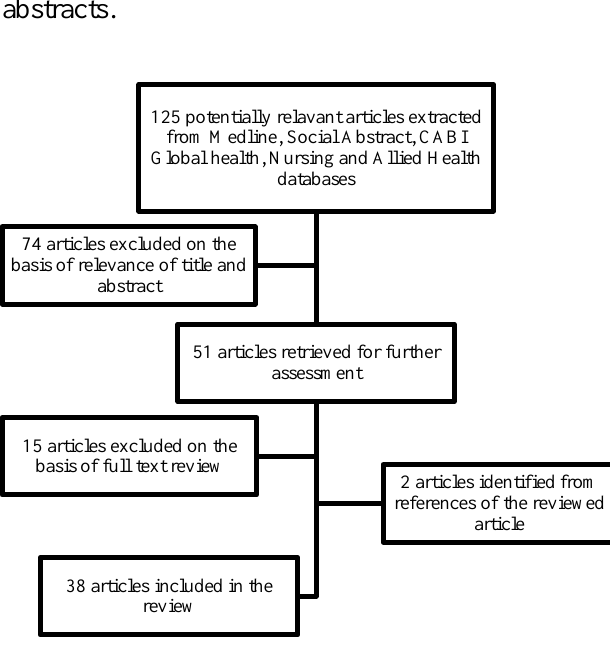
Figure 1: Flow chart of the review Inclusion and exclusion